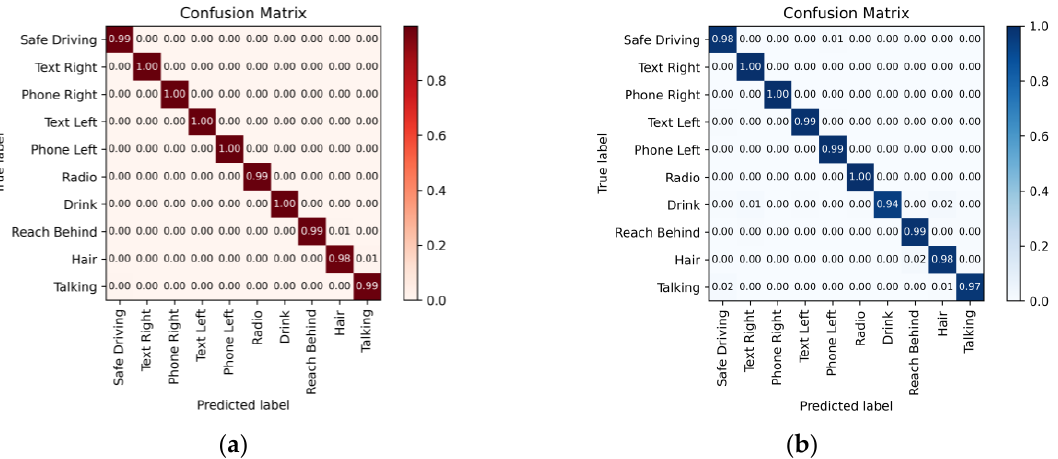
Figure 10. Confusion matrix. ( a ) SF3D dataset. ( b ) AUC2D dataset.